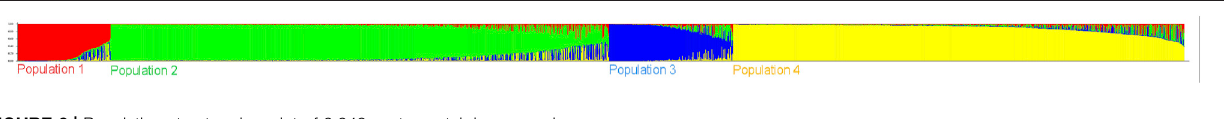
FIGURE 2 | Population structure bar plot of 2,242 east coastal rice